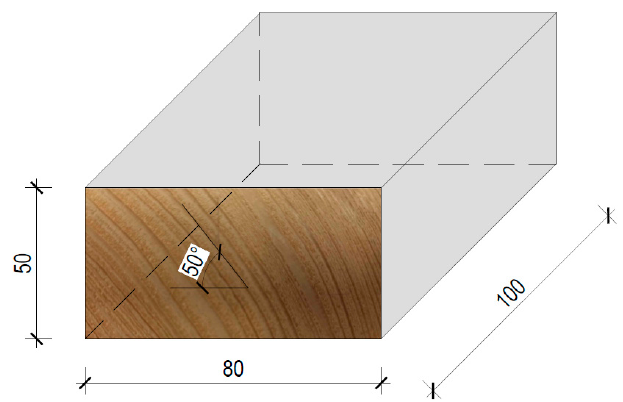
Figure 1. Schema of wood samples for moisture measurement, i.e., a sample with a ring deflection of 50° at a transverse cross-section as a tangentially oriented sample